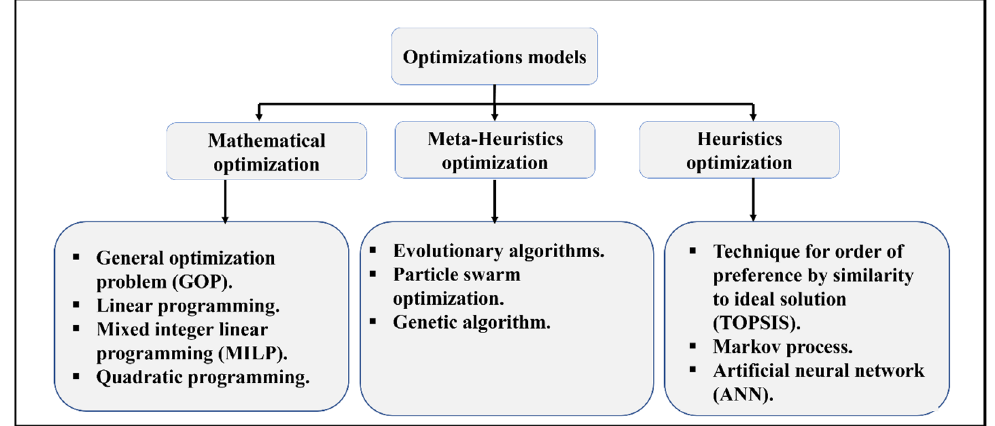
Figure 8. The schematic diagram for the main classification of optimization methods.